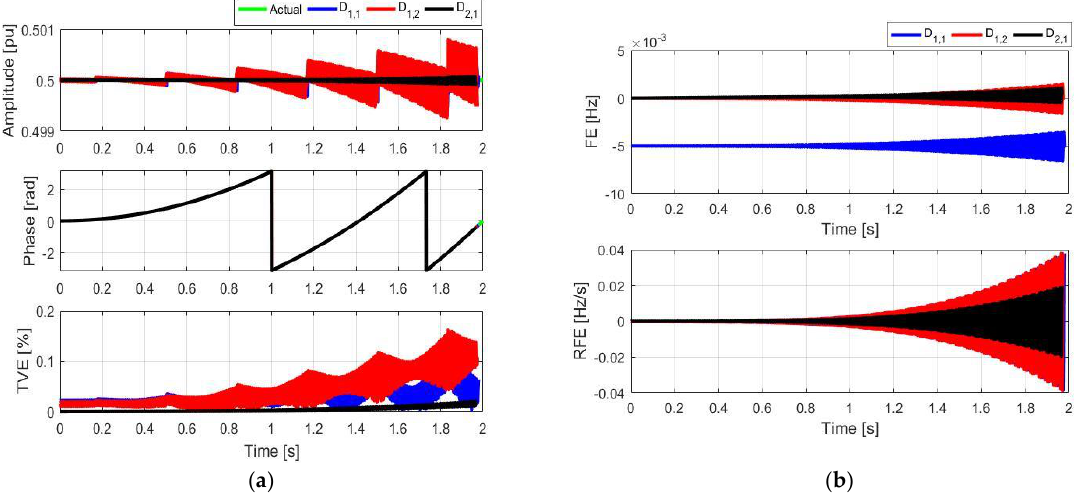
Figure 9. Simulation results obtained for the phase angle step signal, for 𝐾 = 1 for 𝐷 1,1 = 16 and 𝐷 1,2 = 20 , and 𝐾 = 2 for 𝐷 2,1 = 24, with 𝑓 1 = 50 Hz and 𝑓 𝑆 = 800 Hz ( 𝑁 = 16 ): ( a ) amplitude, phase and TVE, and ( b ) FE and RFE.